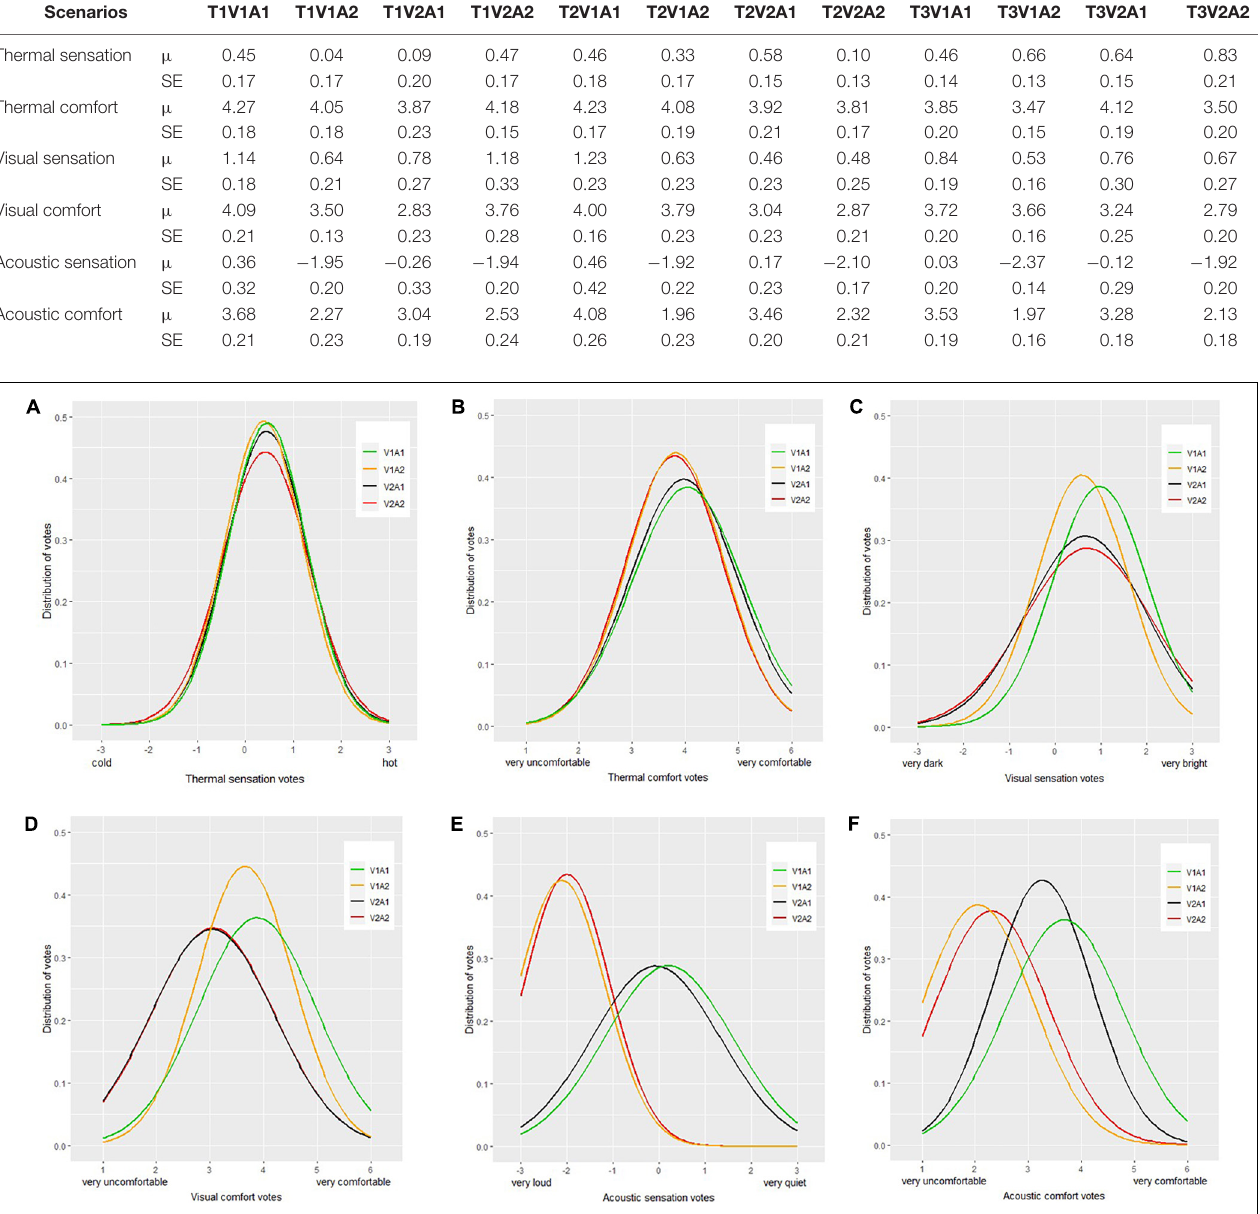
TABLE 6 | Mean ( µ ) and SE of thermal, visual, and acoustic sensation and comfort votes of participants. Scenarios